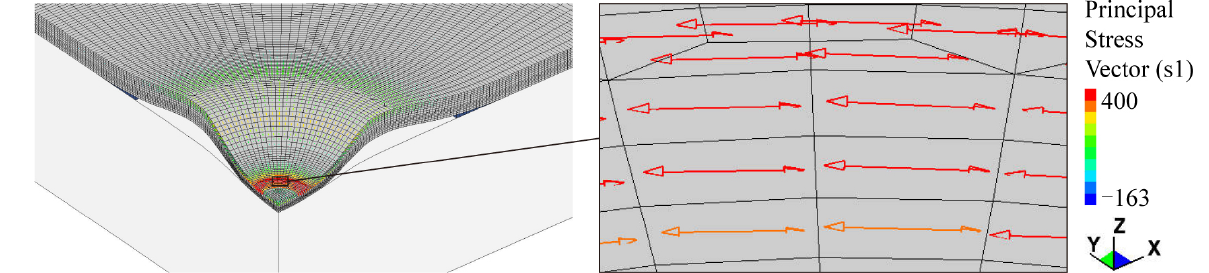
Figure 14. Vector of the maximum principal stress of clearcoat at 11.56 μ s.